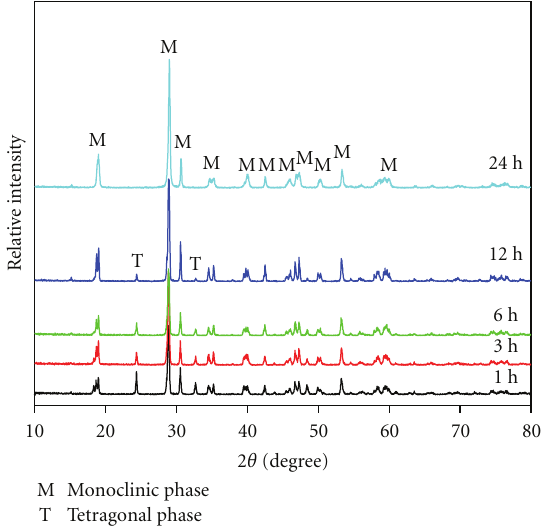
Figure 4: XRD patterns of BiVO 4 samples prepared with 9g urea at di ff erent reaction time from 1, 3, 6, 12 to